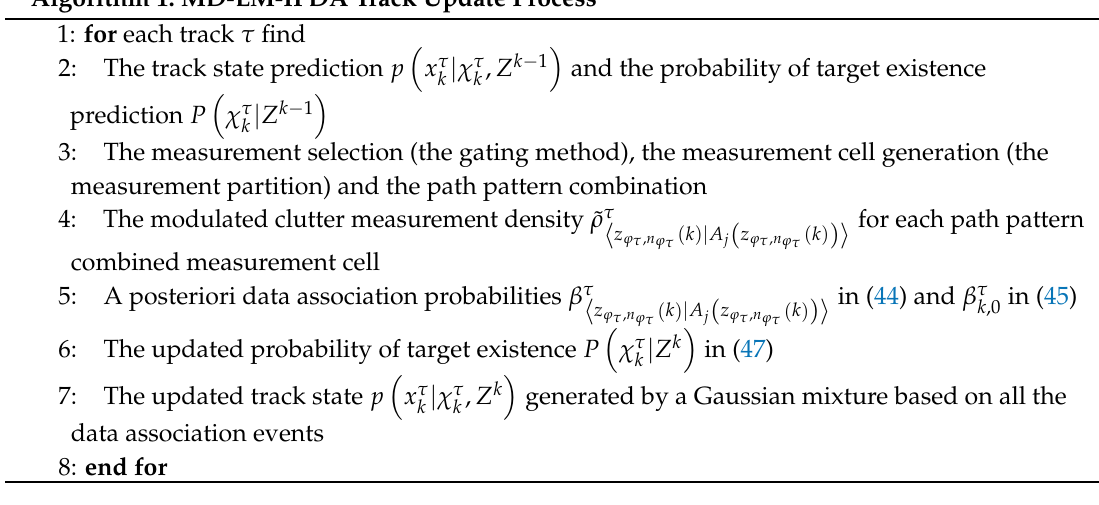
Algorithm 1: MD-LM-IPDA Track Update